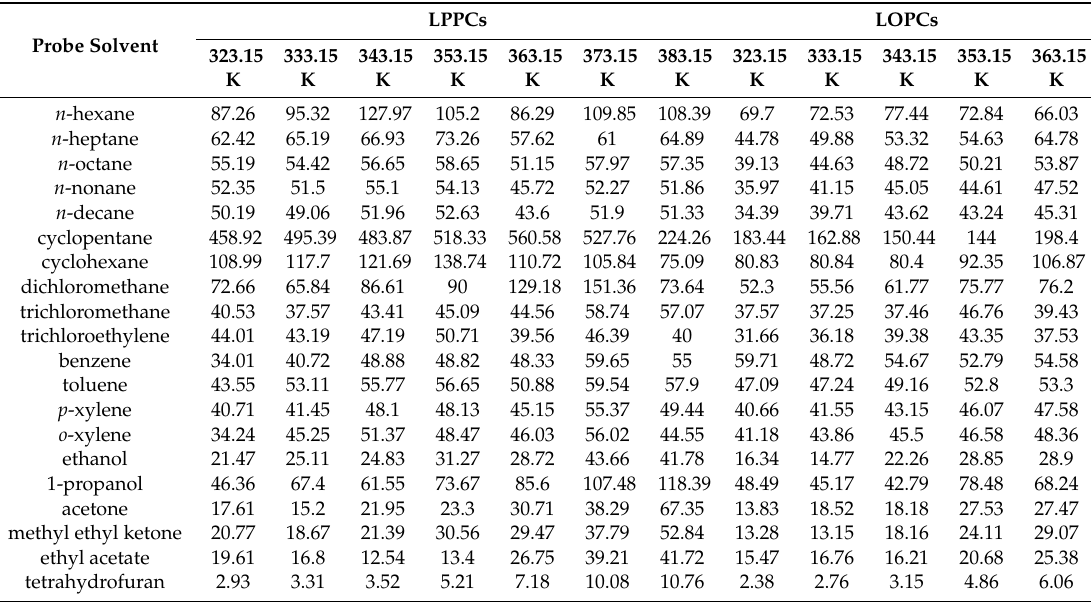
of probe solvents at di ff erent temperatures. 1